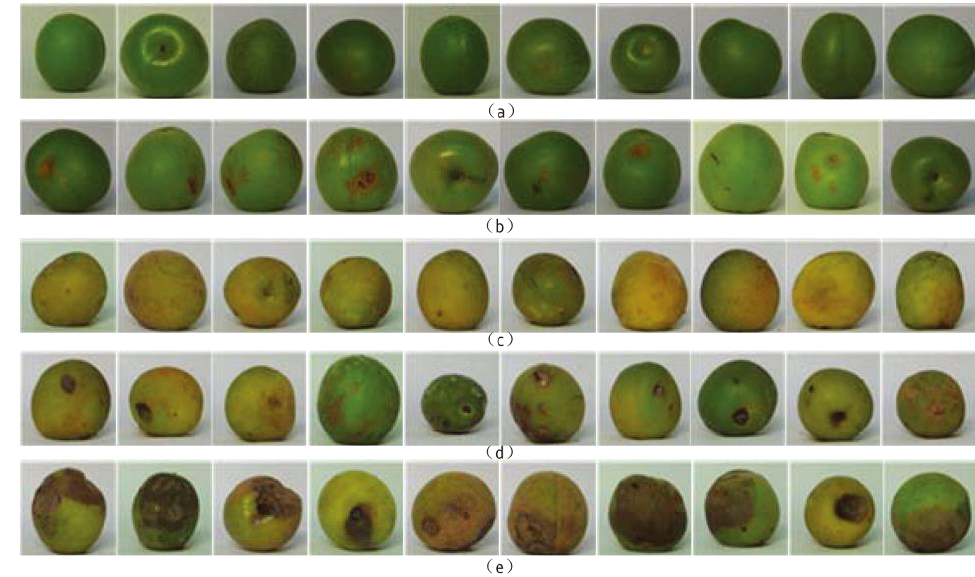
Figure 4. Some typical greengage samples: ( a ) superior products, ( b ) good products with scars, ( c ) defective products, ( d ) defective products with scars, and ( e ) rotten products.